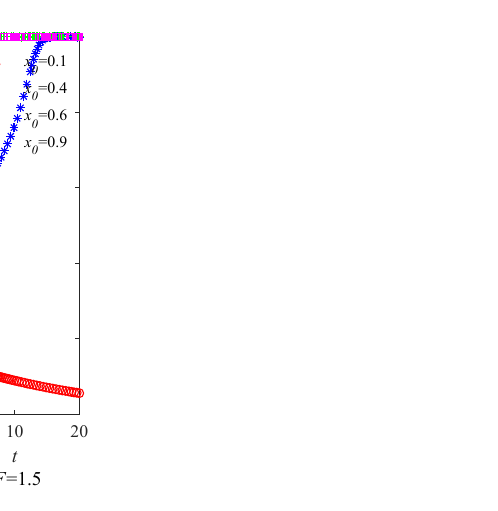
results. results.